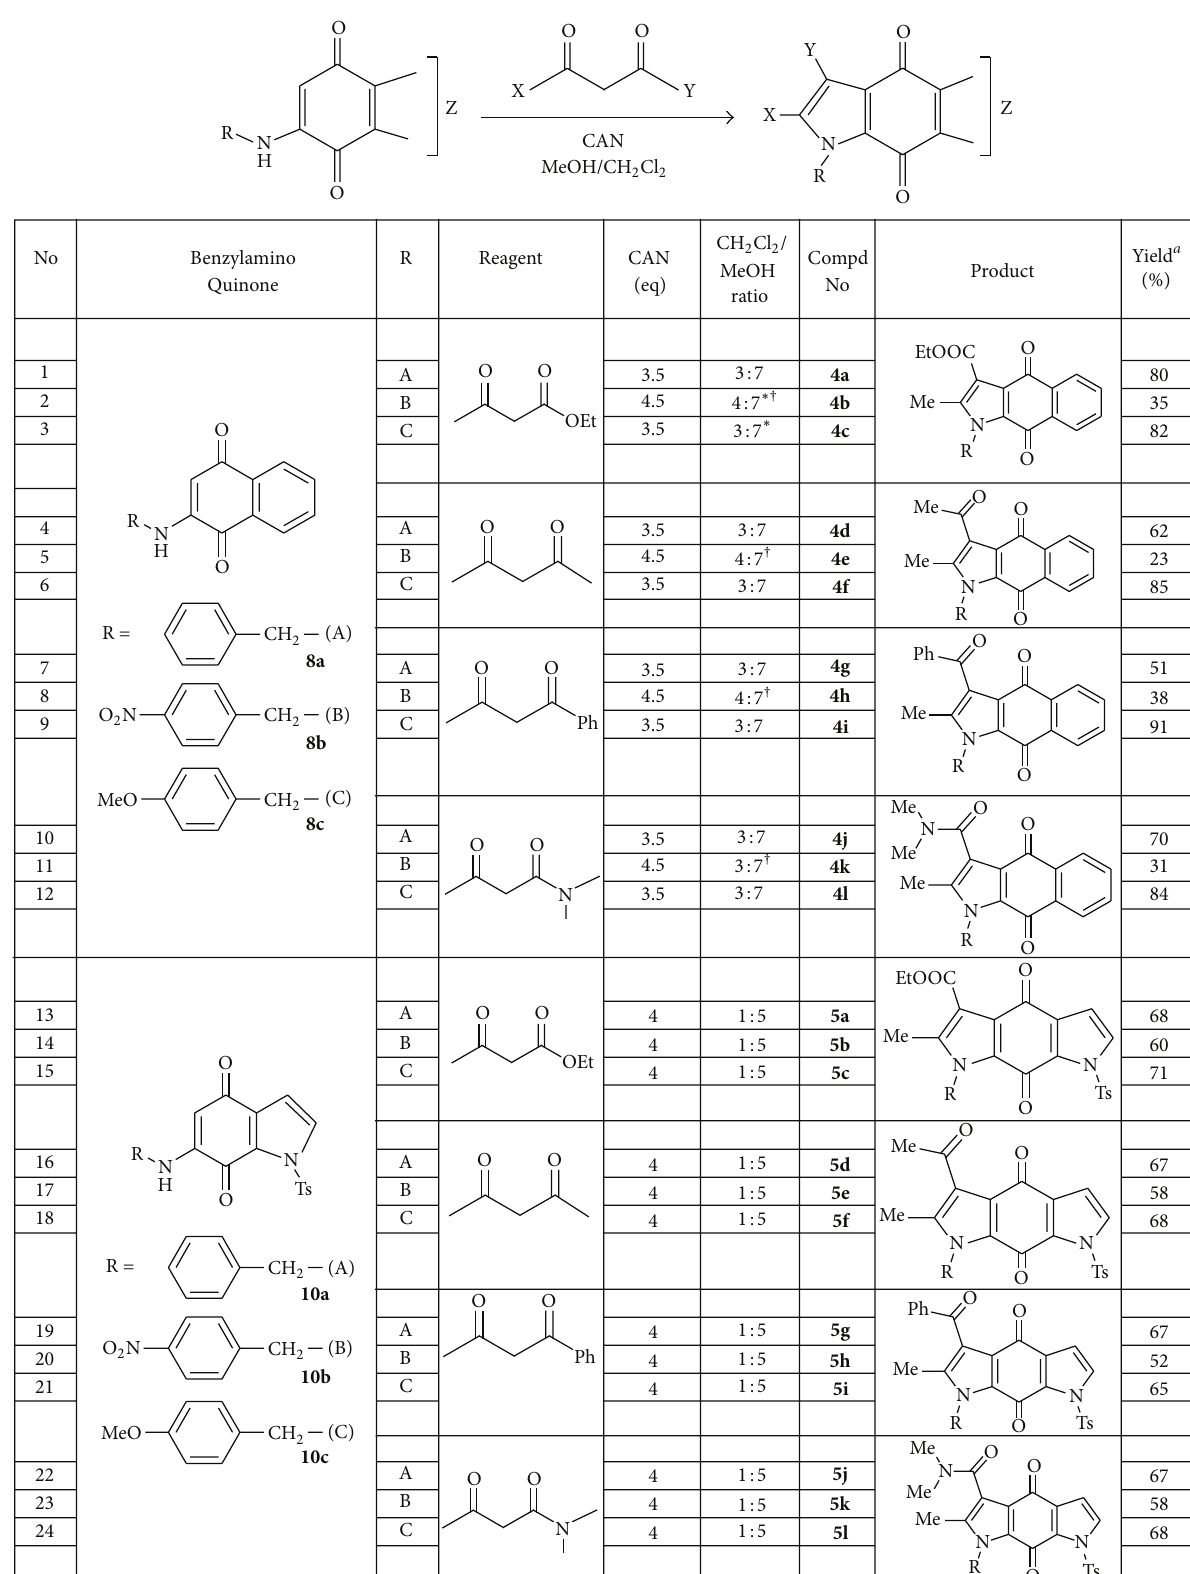
Figure4: CAN-mediated oxidative freeradical cyclization reaction of benzylamino quinonesyielding substitutedN-benzyl pyrroloquinones. a isolated yields; ∗ EtOH/CH 2 Cl 2 mixture was used instead of MeOH/CH 2 Cl 2 to avoid transesterification; heating was used to dissolve starting